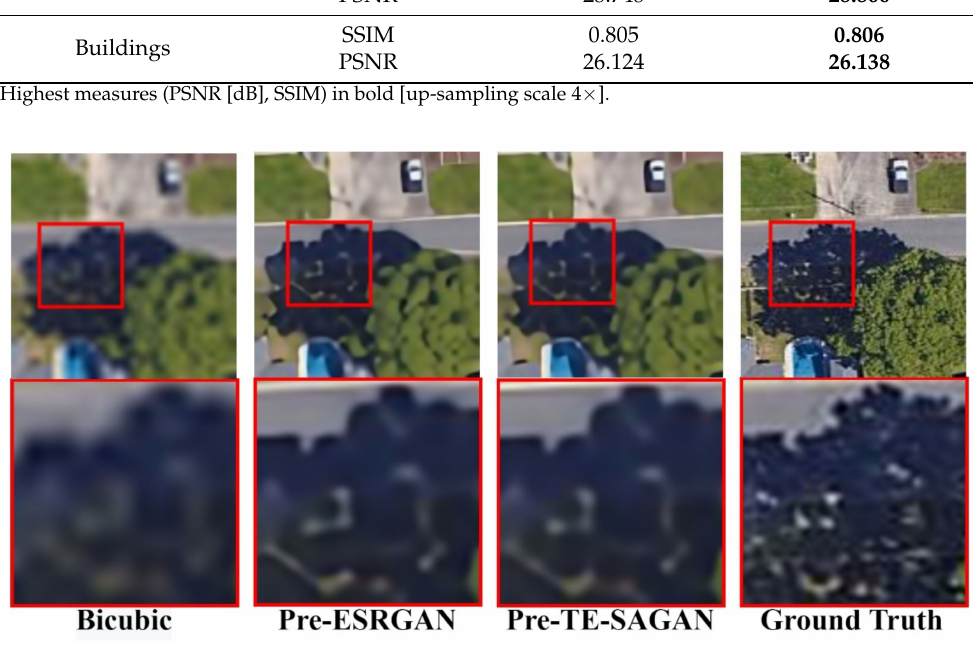
Figure 7. Results of SR processing using the Test-10000 dataset with a scale factor of 4 in the pretraining